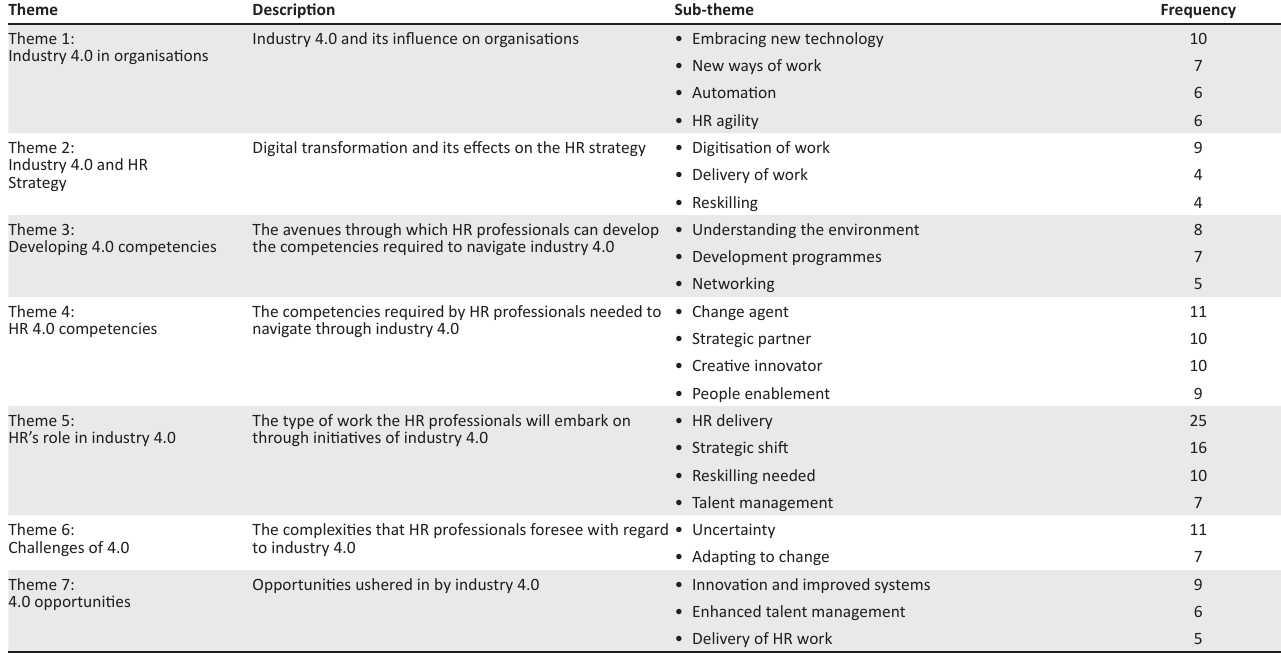
TABLE 2: Themes and sub-themes identified from